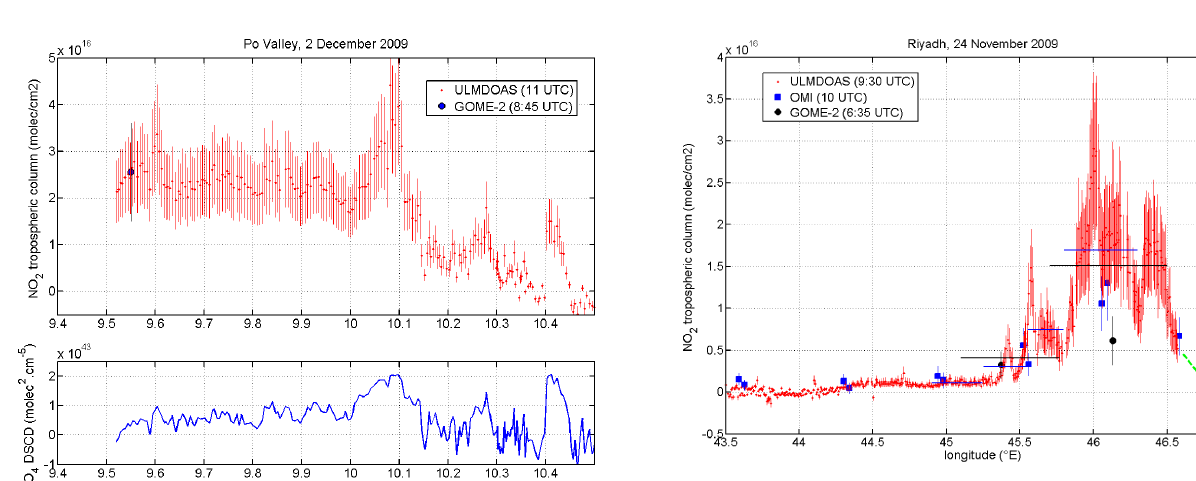
Fig. 11. ULM-DOAS (red), OMI (blue), and GOME-2 (black) mea- surements over Saudi Arabia (24 November 2009). ULM-DOAS data were recorded between 09:07 and 12:03UTC and cover the lat- itude range from 25.18 ◦ to 24.79 ◦ . Horizontal blue and black lines correspond to ULM-DOAS data averaged over OMI and GOME-2 pixel extensions, respectively. ULM-DOAS tropospheric NO 2 mea- surements are larger in this case than the ones seen by both satel-